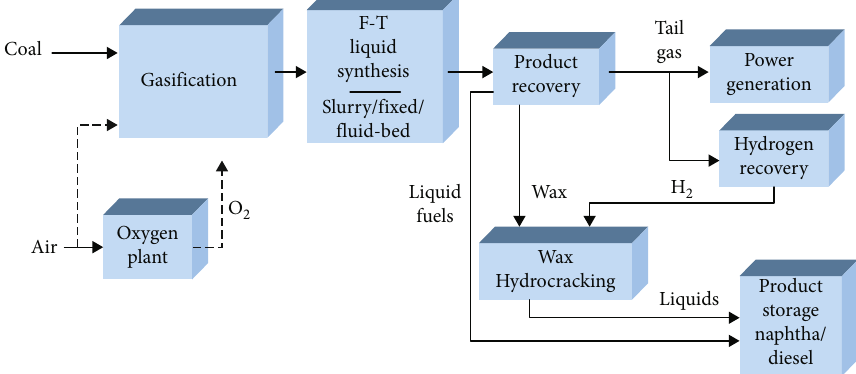
Figure 14: Simpli fi ed F-T Synthesis-based Production Scheme